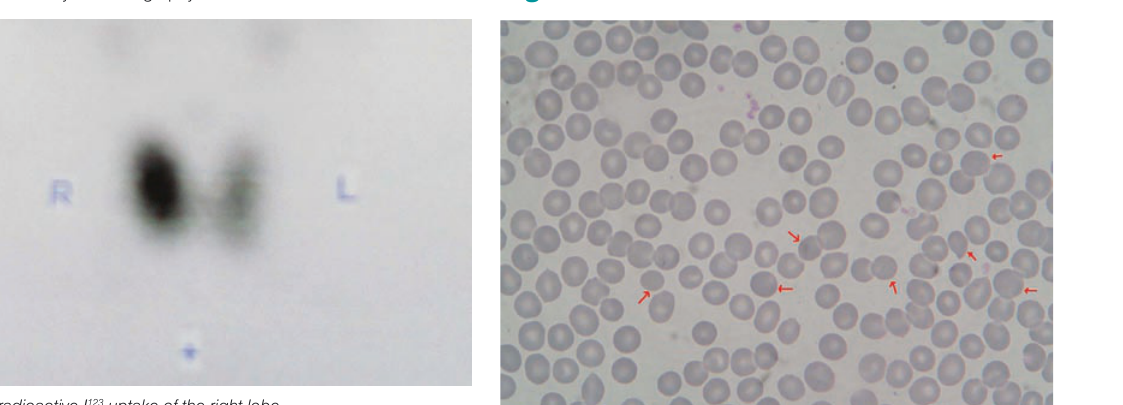
Figure 1. Thyroid